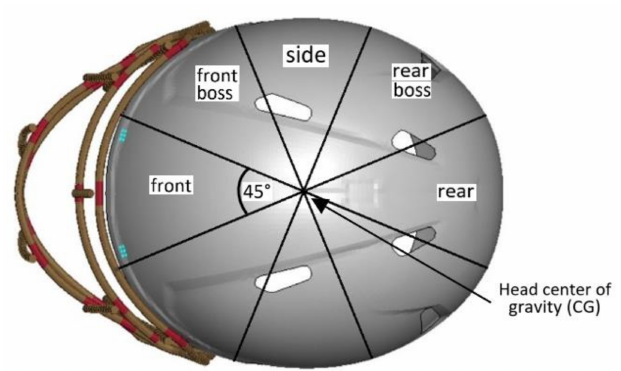
Figure 5. Impact location bins (based on